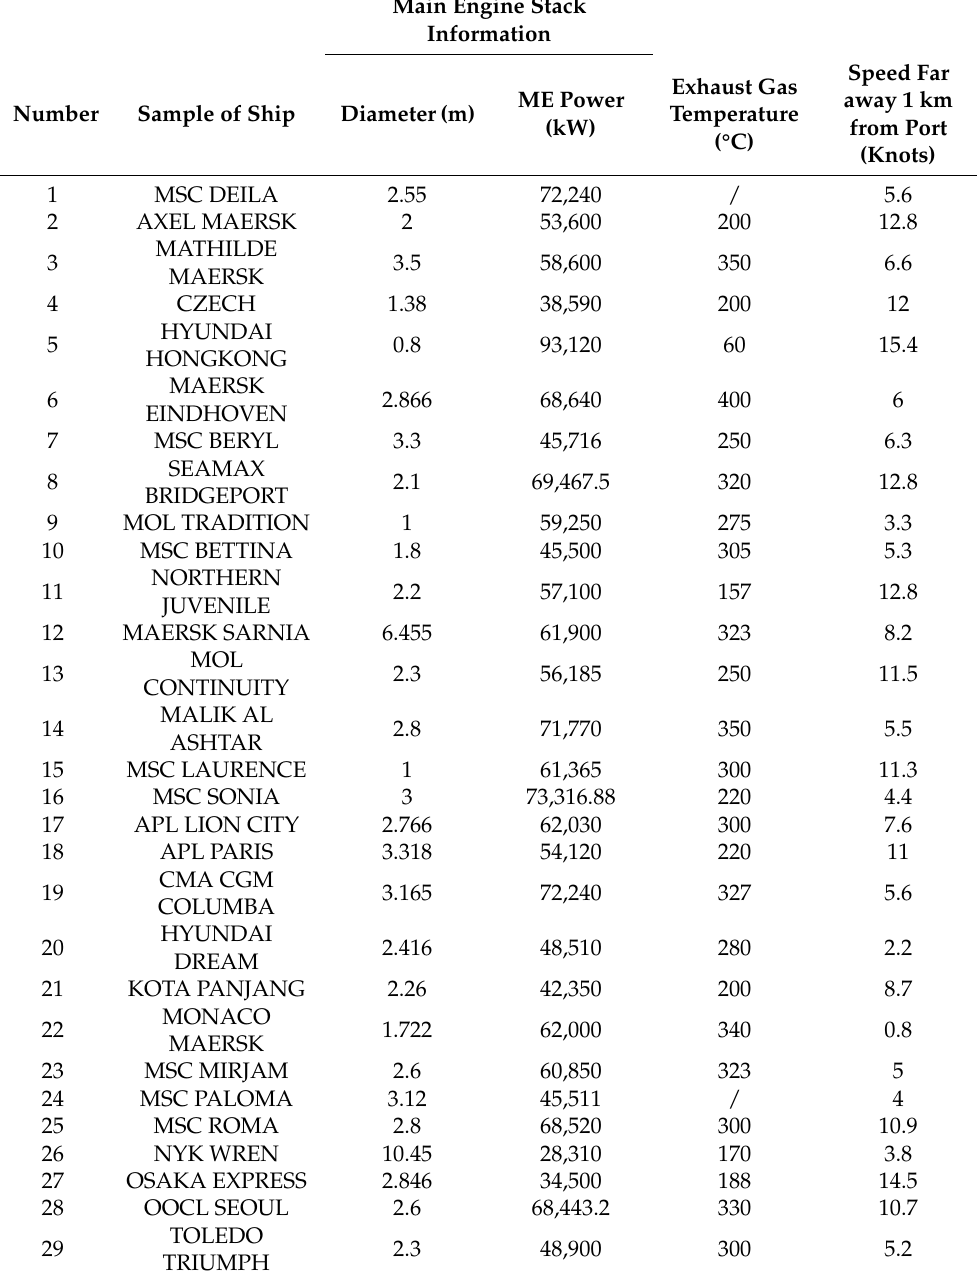
Table A1. Basic information of the port of the ship sample in Dapeng Bay, Shenzhen in June